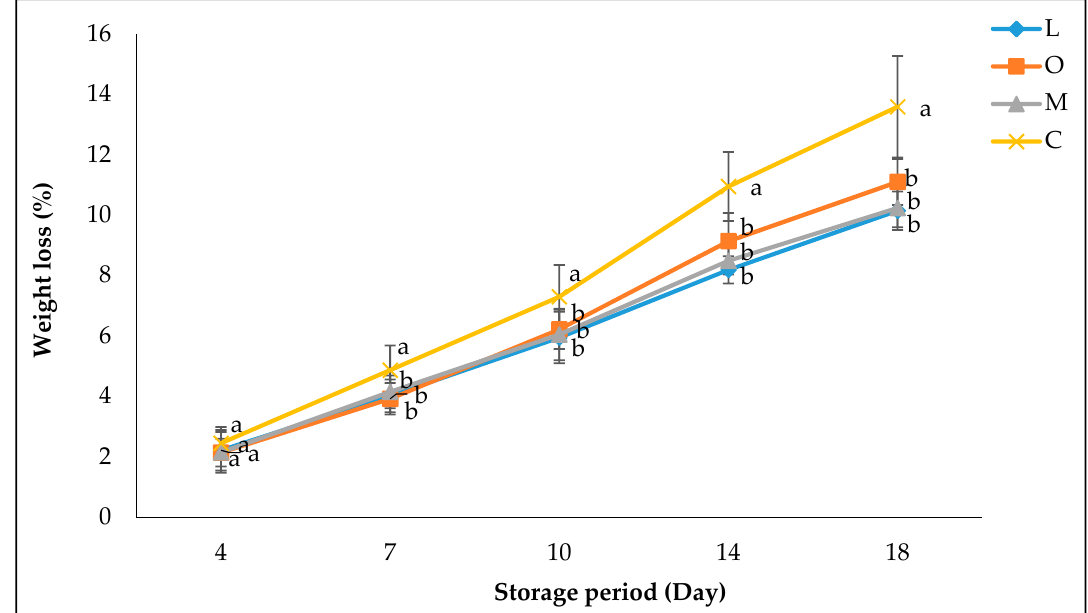
Figure 2. Effect of edible emulsion incorporated with essential oils (L = lemon, O = orange and M = Figure 2. E ff ect of edible emulsion incorporated with essential oils (L = lemon, O = orange mandarin essential oil) on weight loss percentage of strawberry fruits at 2 °C. Vertical bars indicate and M = mandarin essential oil) on weight loss percentage of strawberry fruits at 2 ◦ C. Vertical bars standard deviation (n = 6). Means and different letters indicate significant difference between treated indicate standard deviation (n = 6). Means and di ff erent letters indicate significant di ff erence between and control fruits at each storage period (Duncan’s of 95%). treated and control fruits at each storage period (Duncan’s of